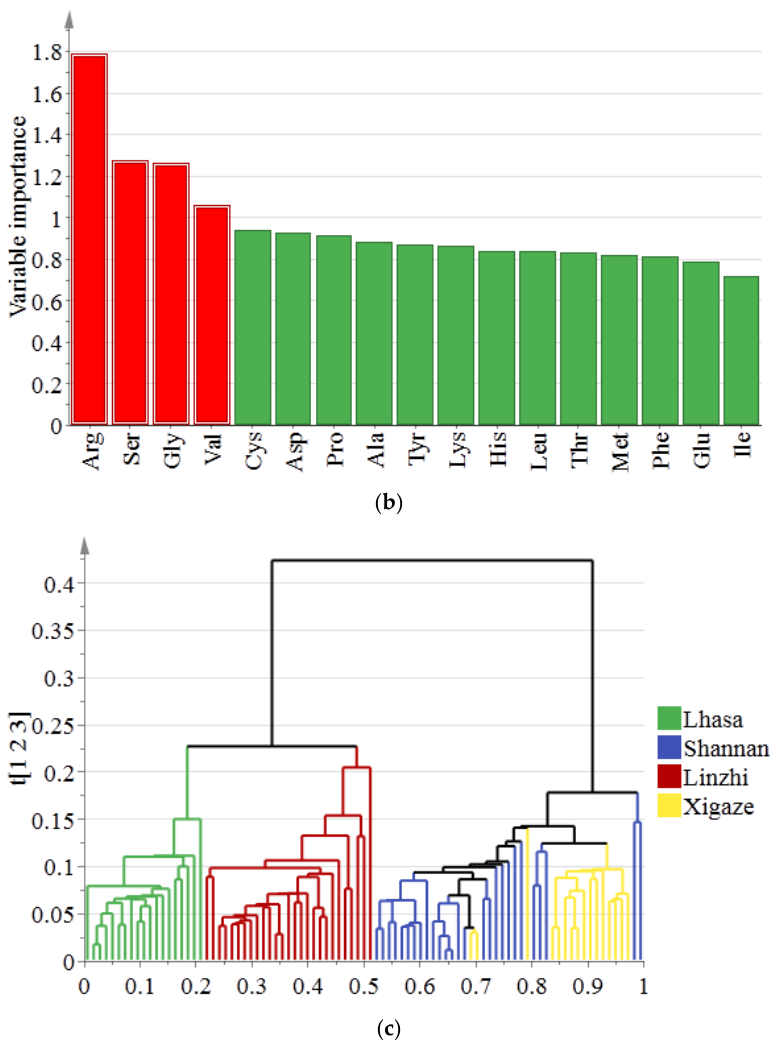
Figure 2. The OPLS-DA plot of Tibetan chicken from four regions with the data on amino acids ( a ); the variable importance projection of Tibetan chicken samples from four regions of Tibet with data on amino acids ( b ); the HCA plot of amino acids in Tibetan chicken from four cities ( c ). Table 2. Classification of Tibetan chicken samples based on amino acids by LDA. Predicted Group Membership